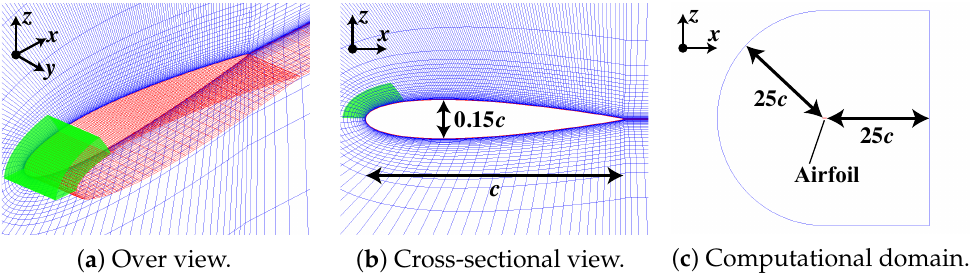
Figure 4. Computational grids and domain. The grids were visualized for every four points. The distance from the airfoil surface to the outer boundary was 25 c , and the width of the span-wise computational domain was 0.2 c . The grid points of zone 1 and zone 2 were approximately 1.8 × 10 7 and 2.0 × 10 6 , respectively, as shown in Table 1. The minimum grid spacing in the wall-normal direction was 0.00012 c . The maximum grid sizes based on the wall unit were ( ∆ ξ + , ∆ η + , ∆ ζ + ) (cid:46) ( 8, 9, 1 ) at the attached turbulent boundary layer region. The present grid resolution and the computational methods were validated in the previous study